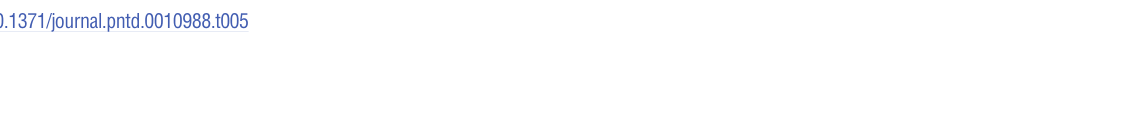
Table 5. Practices among general people regarding Congo ( N = 535).